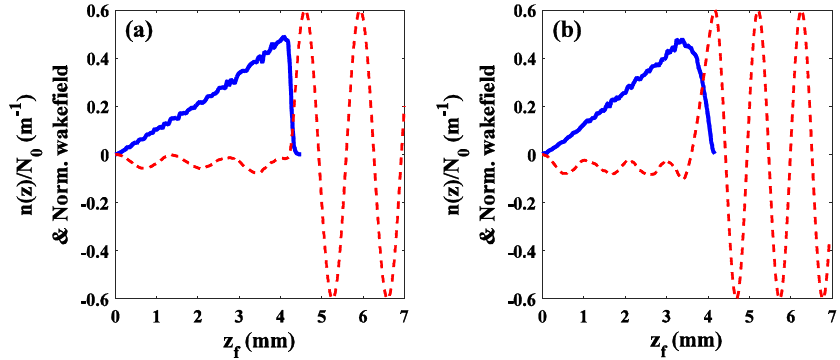
FIG. 12. Final longitudinal bunch shape (blue) and corresponding wakefield (red) for the CSR dominant case (a) and the SC dominant case (b). In both cases, we used a 12-degree bending angle with a charge after the mask of 3.5